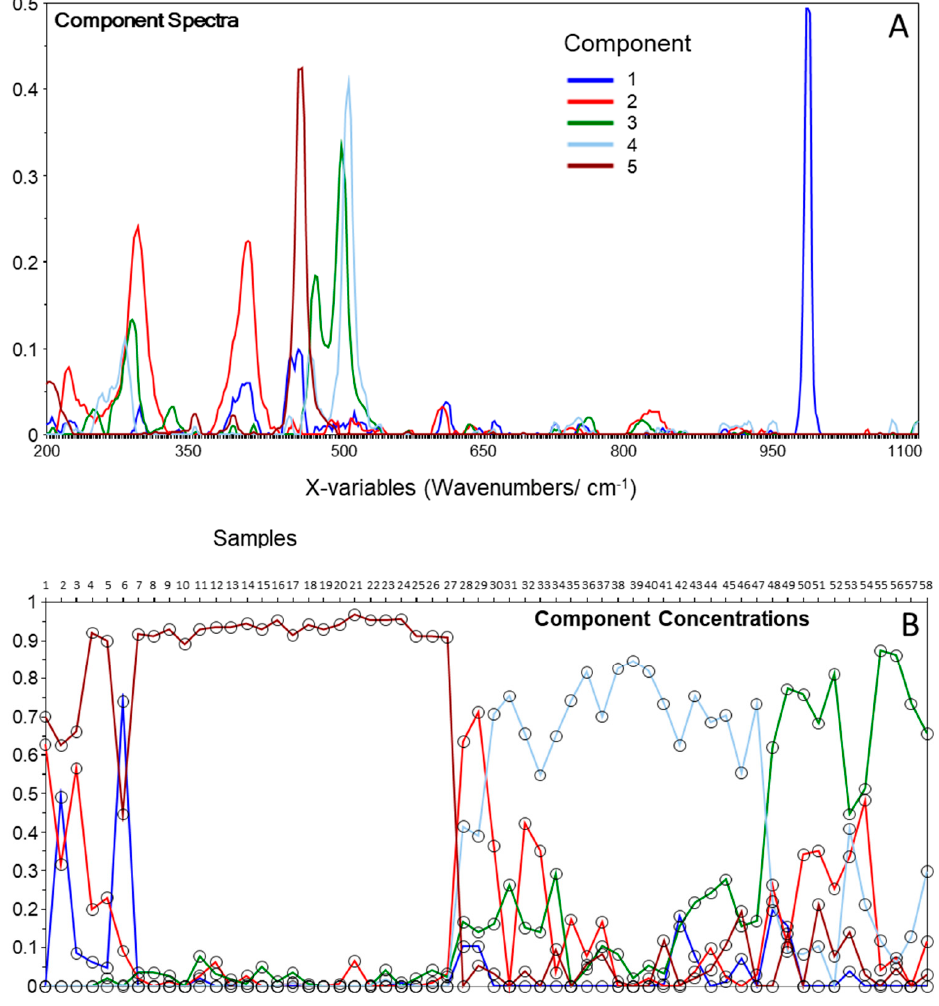
Figure 2. Components’ spectra ( A ) and components’ concentrations ( B ) plots resulting from MCR analysis of the Raman spectra of the core section of the fulgurite. The components’ spectra were vector-normalized.